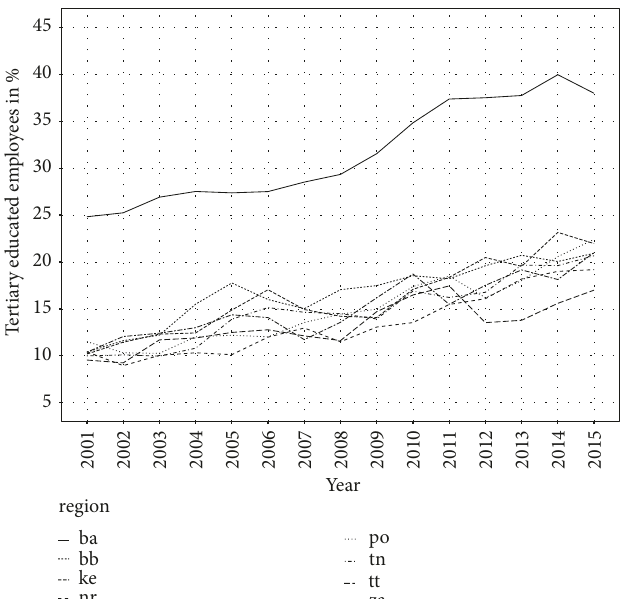
Figure 7: Percentage of tertiary educated employees in Slovak regions.